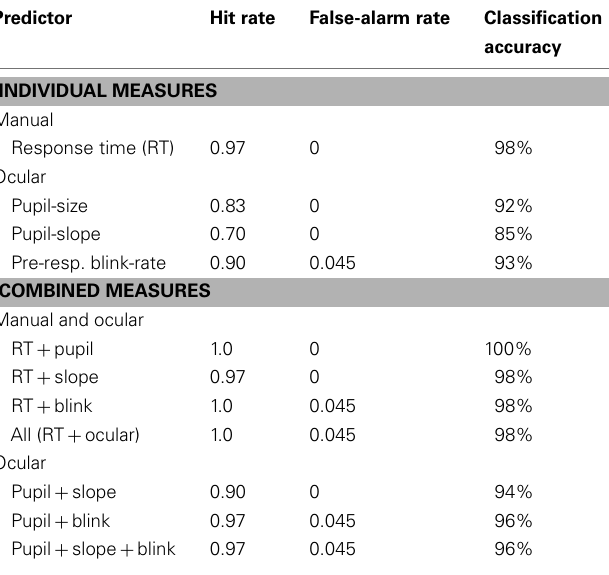
Table 2 | Results from the compound classification procedure (variance-ratio and Kolmogorov–Smirnov tests only) for individual and combined